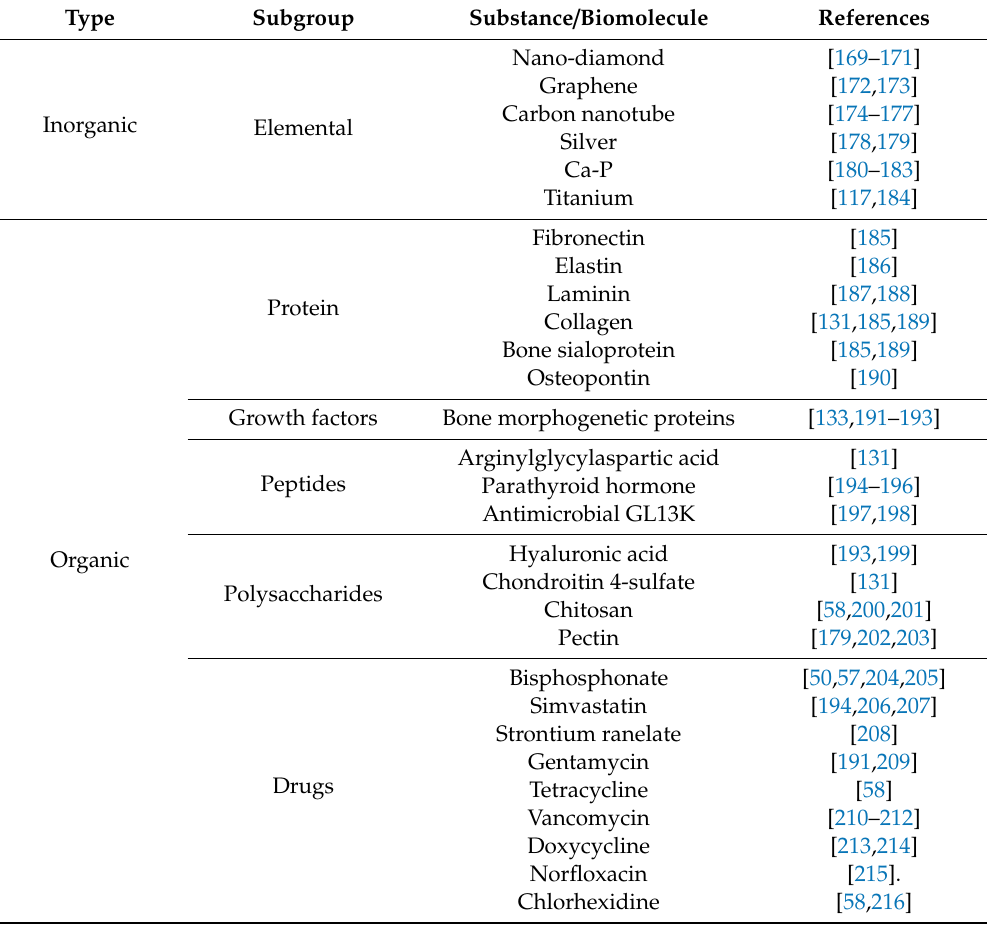
Table 2. List of various materials and biomolecules studied as potential therapeutic dental implant coating